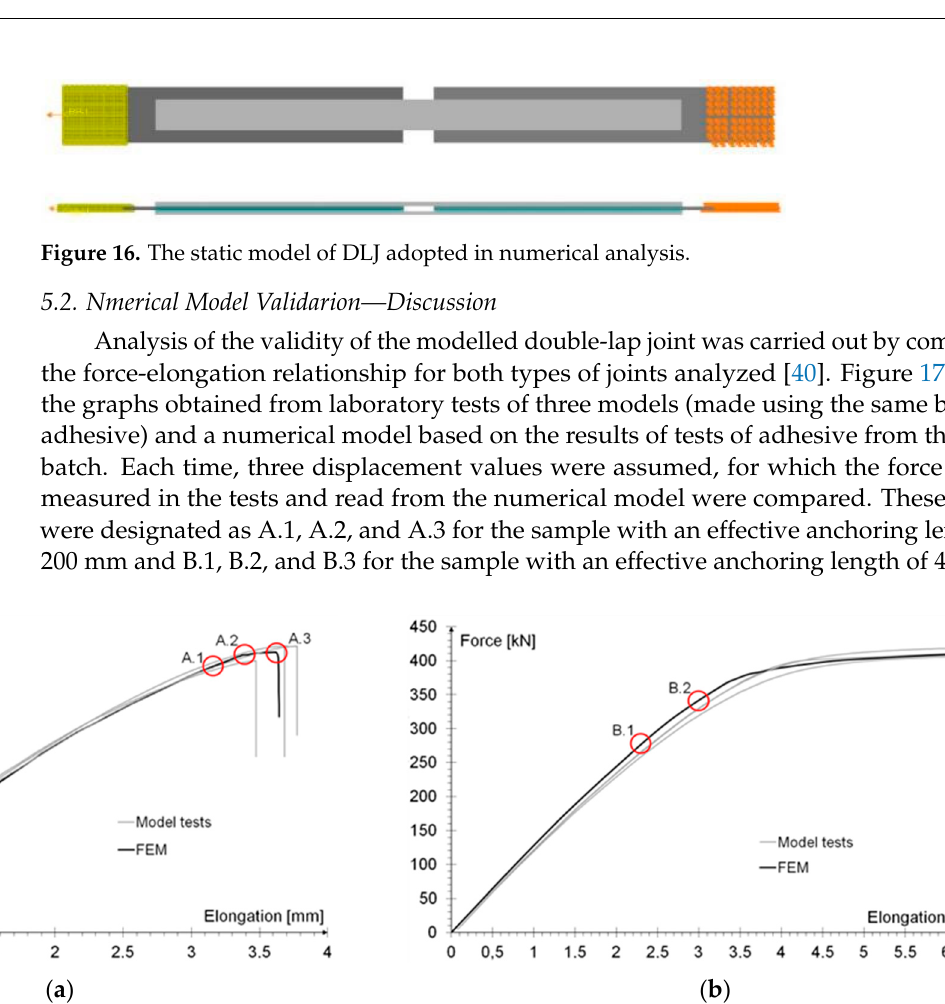
Figure 15. View of the joint in the middle of the specimen: ( a ) numerical model; ( b ) laboratory test.